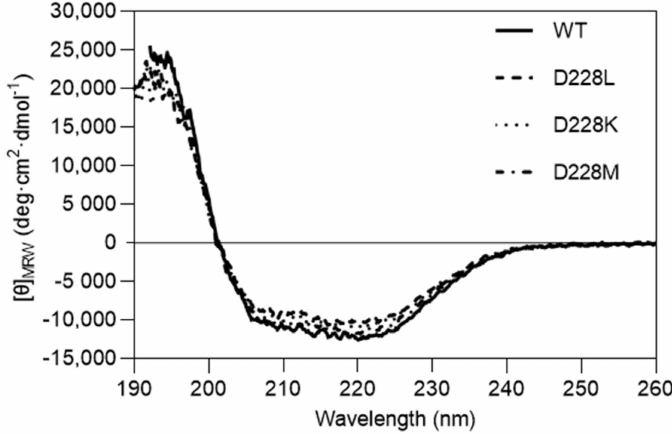
Figure 2. Far-UV CD spectra of KPC-3 and D228K, D228M and D228L mutants. Data were obtained at 20 ◦ C, in 25 mM sodium phosphate bu ff er, pH 7.0. Calculated secondary structural contents from these spectra are (34 ± 3)%, (18 ± 2)%, (19 ± 1)% and (29 ± 2)%, for α -helices, β -strands, turns and unordered,